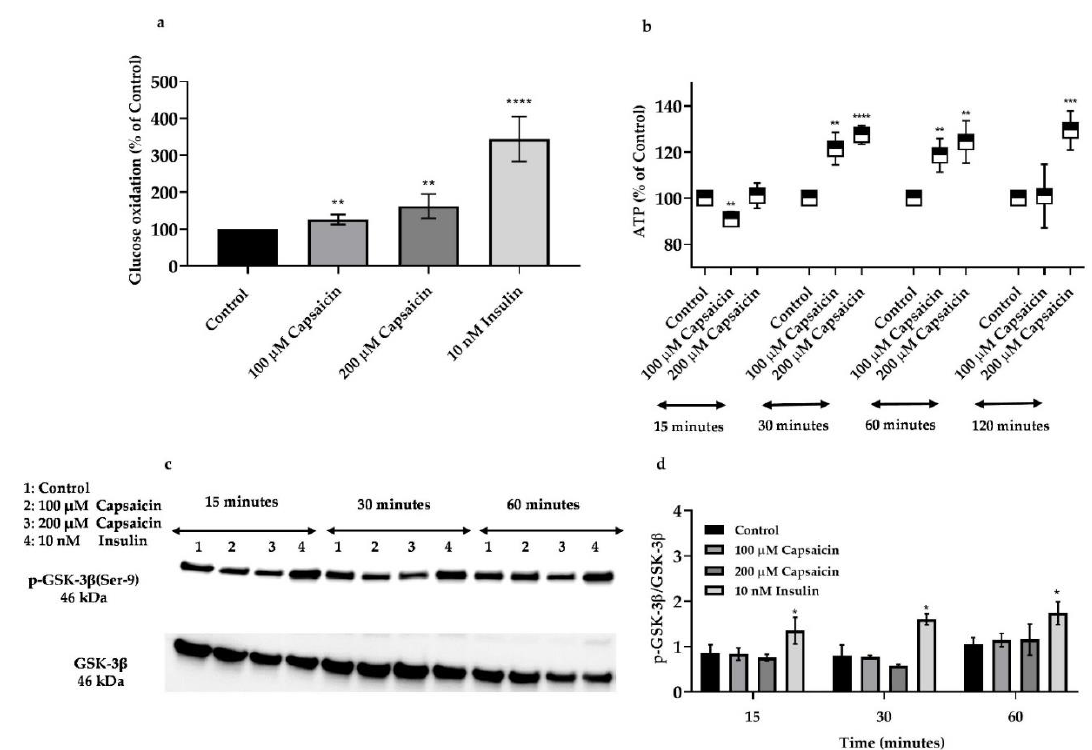
Figure 6. Glucose oxidation levels, ATP levels, and Western blot analysis for phosphorylated and total GSK-3 β in capsaicin and insulin-treated mouse skeletal muscle cells. ( a ) Glucose oxidation levels following 60 min incubation with 100 and 200 µ M of capsaicin and 10 nM insulin. ( b ) Intracellular ATP generation in the 0, 100, and 200 µ M capsaicin treated cells over 120 min incubation. ( c ) Representative Western blot for p-GSK-3 β in the presence and absence of capsaicin and insulin over 60 min incubation. ( d ) Relative densitometric bar graph of GSK-3 β in the capsaicin and insulin-treated mouse skeletal muscle cells over 60 min. Data are presented as mean ± SD of three independent repeats ( n = 3). * p < 0.05, ** p < 0.01, *** p < 0.001, and **** p < 0.0001 indicate a significant difference between capsaicin/insulin-treated and control groups.